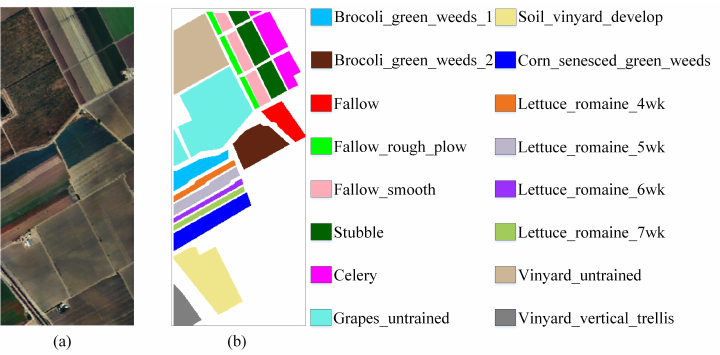
Figure 8. The SA dataset. ( a ) False-color image. ( b ) Ground-truth map. Table 1 lists the number of training samples, testing samples and land-cover category names for the IP, PU and SA datasets. The training sample number of the IP dataset accounts for 10% of the total and the training sample number of the PU and SA datasets accounts for 5%. Table 1. The number of training and testing samples of each category for the IP, PU and SA datasets.